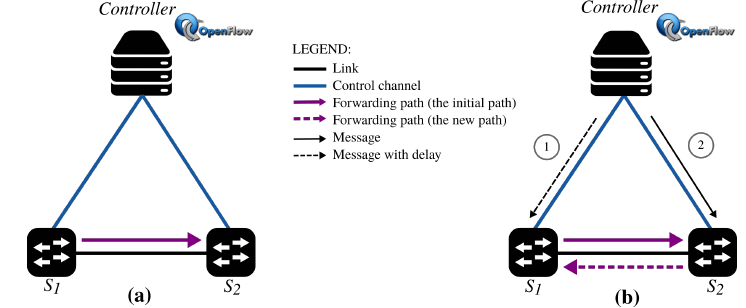
Figure 2. Flow swap scenario: ( a ) initial forwarding policy; ( b ) after updating the initial forwarding